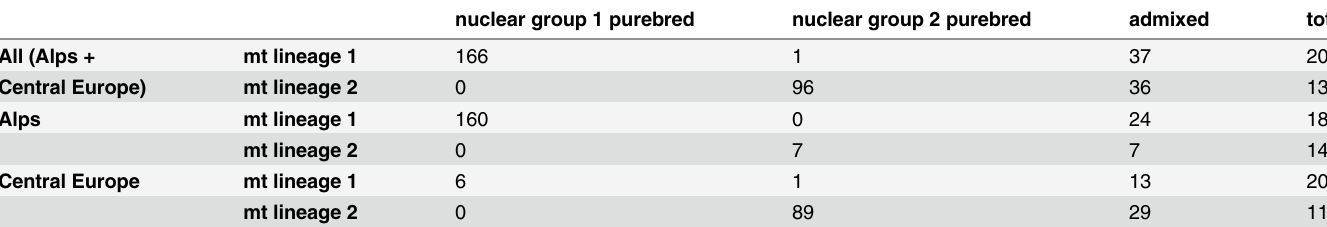
Table 1. Counts of mito-nuclear genotype combinations found in 40